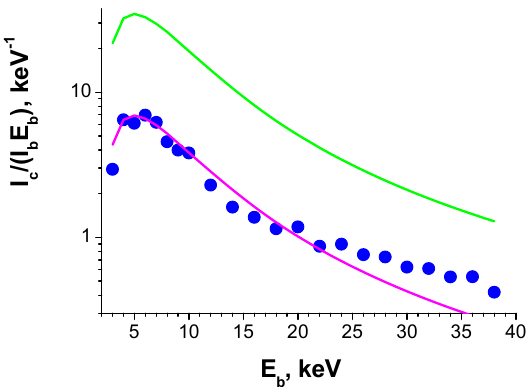
Figure 18. Measured (blue symbols) and calculated (lines) normalized collected current depend ‐ encies on beam energy E b . Magenta line is the simulated dependences and the green one is calcu ‐ lated with η / E i = 0.05 eV − 1